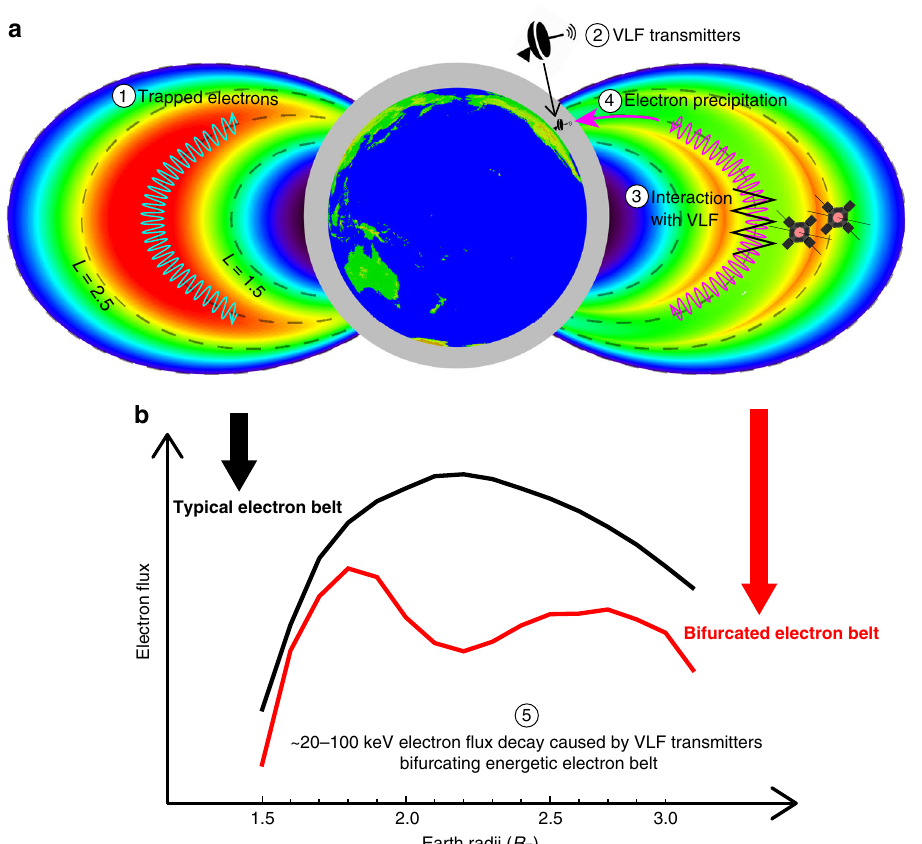
Fig. 4 Schematic illustration of bifurcating energetic electron belt (tens of keV) caused by VLF transmitters. a Electron fl uxes before (left side) and after (right side) resonant wave-particle interactions with VLF transmitter waves. b Variations of radial energetic electron fl ux pro fi le from a typical (single-peak) structure to a bifurcated (double-peak) belt. There is a multi-step process to directly link the bifurcated electron belt in space to VLF transmitters at ground: ① Electrons are trapped by the geomagnetic fi eld and populate the energetic electron belt over L ~ 1.5 – 2.5. ② Ground-based VLF transmitter signals leak into space. ③ VLF transmitter signals interact with counter-streaming energetic electrons along the fi eld line, and ④ drive their precipitation loss into the atmosphere at selected energies. ⑤ Consequently, local electron fl ux minimum is formed for tens of keV electrons at L ~ 1.8 – 2.5 on a timescale of ~10 days, leading to a bifurcated energetic electron